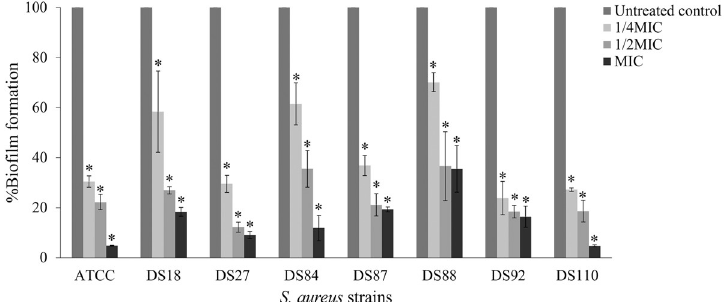
Fig 3. The activity of sericin extract against biofilm formation by S . aureus ATCC 29213 and clinical isolates. Statistical significance at � p < 0.05 compared with the untreated control.